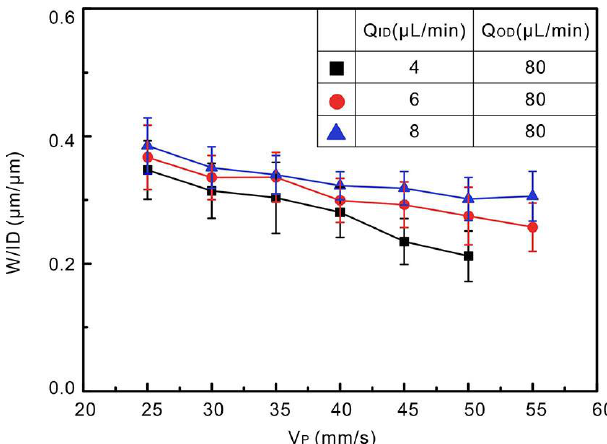
Figure 7. Trace widths normalized by ID as a function of the platform speed. Three different ratios of Q ID /Q OD were used for study (ID = 210 μm, OD = 800 μm). There is no continuously trace when the moving speed is over 50 for small liquid alloy flow rate (black squares).